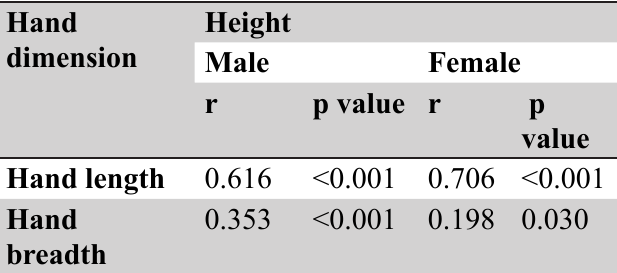
Fig 2: Relationship between height and hand length in